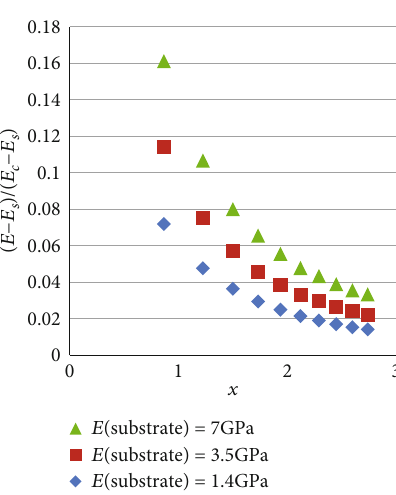
Figure 5: E ff ects of varying E (substrate) on the mechanical response of the coating/substrate system.